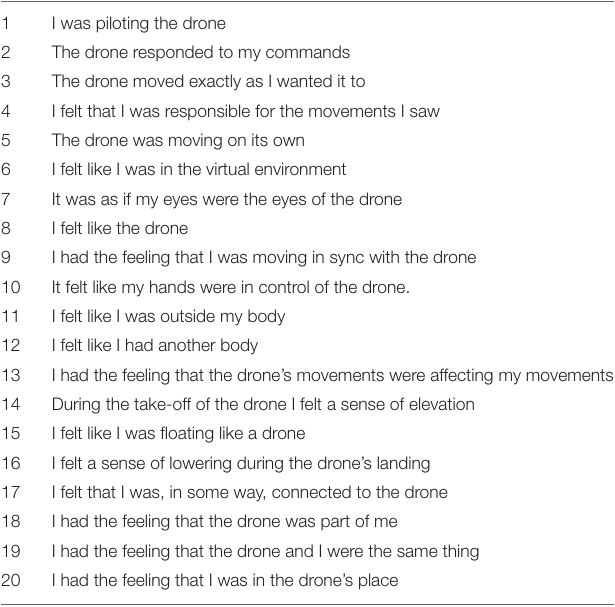
TABLE 1 | Items of the embodiment questionnaire used in this